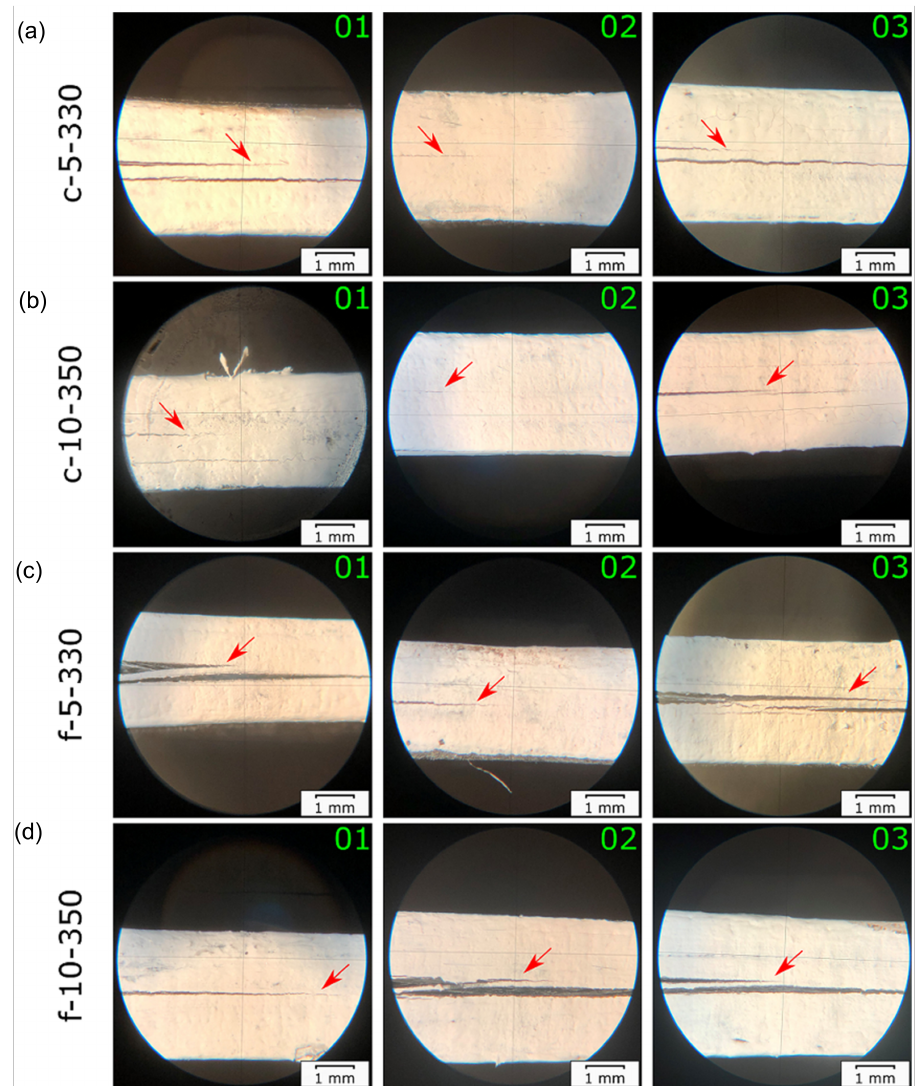
Figure 6. Illustrative images of delamination growth in: ( a ) c-5-330; ( b ) c-10-350; ( c ) f-5-330; ( d ) f-10-350 tested under fatigue. Three specimens for every laminate are presented and sequentially numbered with 01, 02, and 03. The pictures were taken when the crack length reached about 40 mm. The red arrows point at the mid-plane